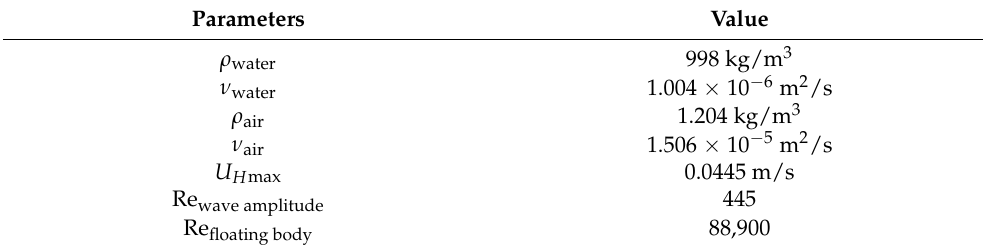
Table 1. Flow parameters.